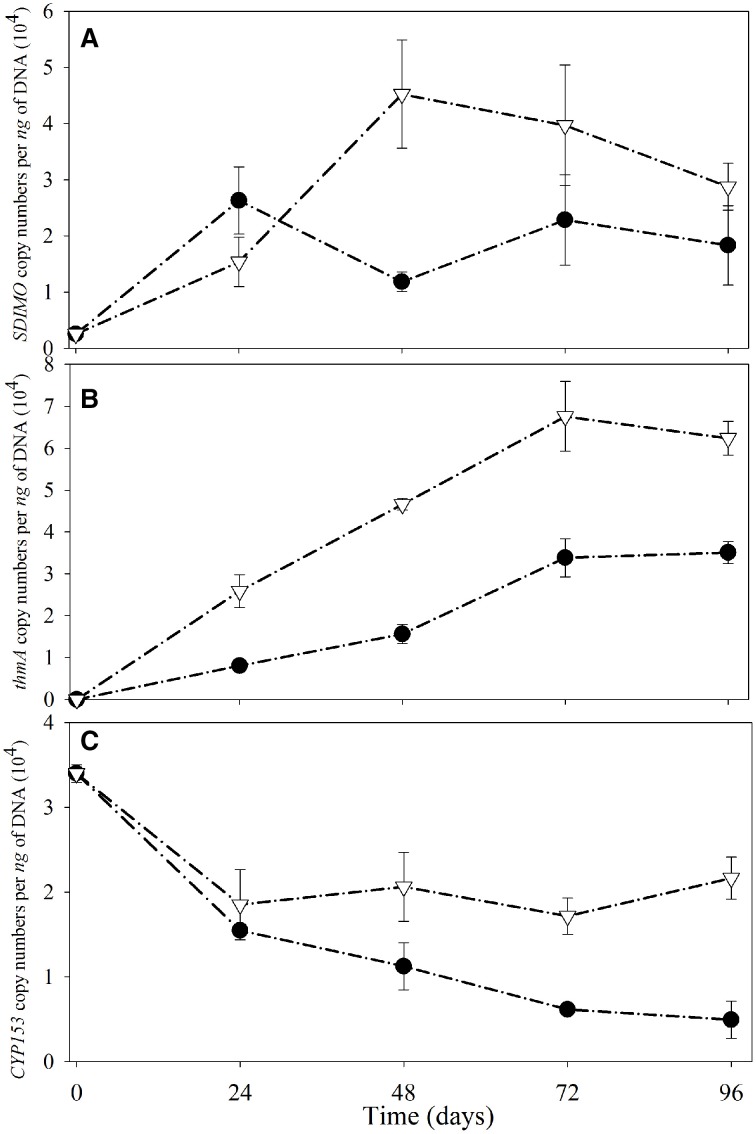
Quantitative analysis of SDIMO (A), thmA (B), and CYP153 genes (C) from activated sludge samples at different periods during reactor operation. The black dot represents the non-trehalose BA reactors; the white triangle represents the trehalose BA reactors.